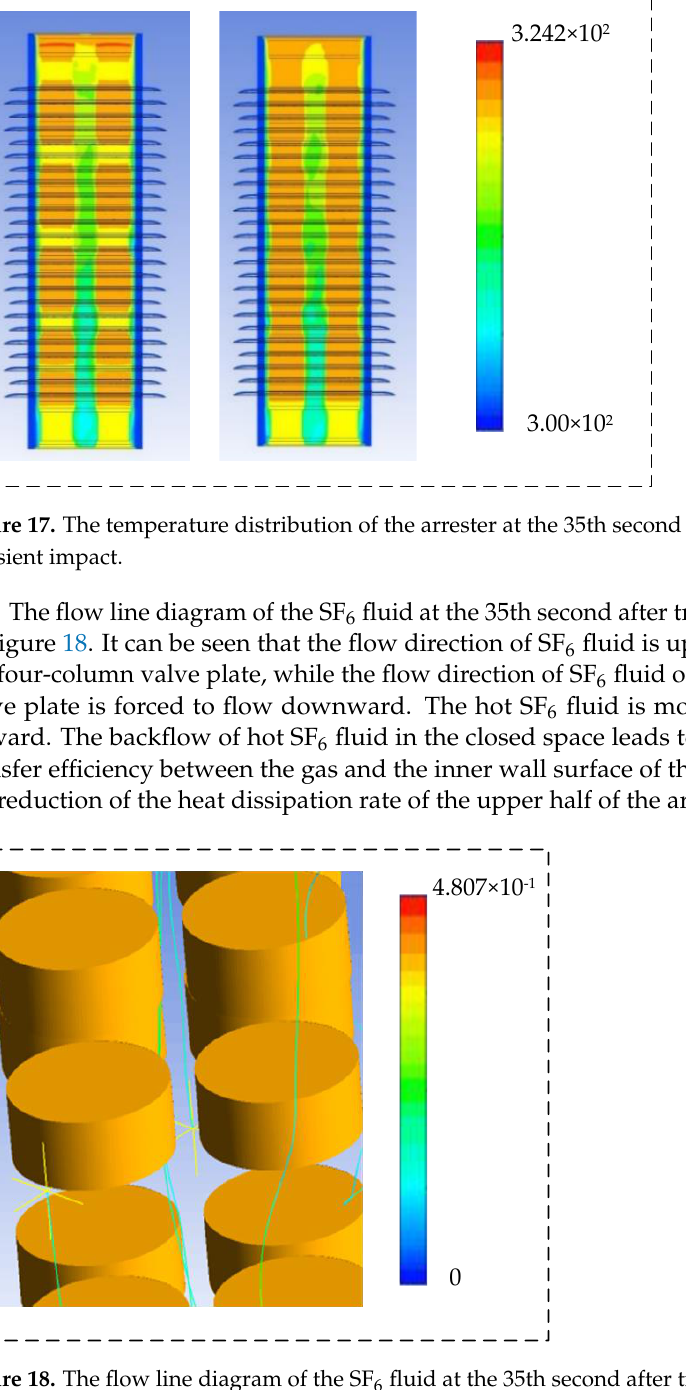
Figure 18. The flow line diagram of the SF 6 fluid at the 35th second after transient impact.